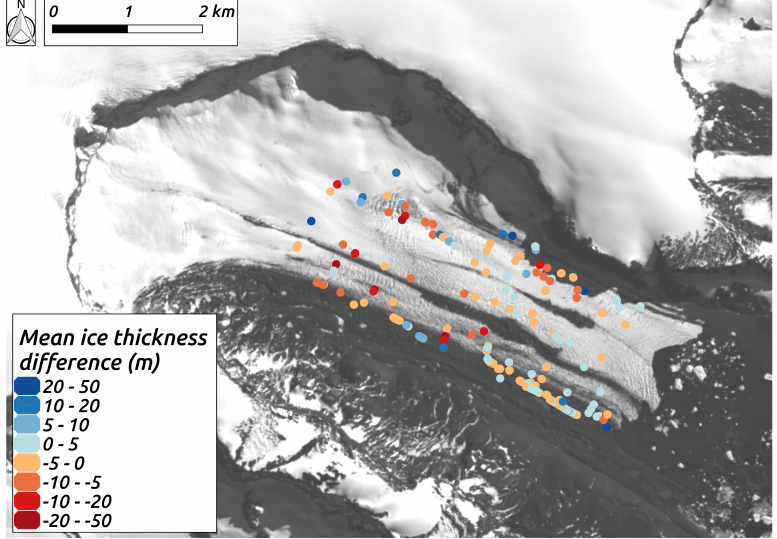
Figure 7. Mean ice thickness difference between 2018 and 2017 within a search radius of 2.7m. Background image: Landsat-8 (20 February 2017, courtesy of the U.S. Geological